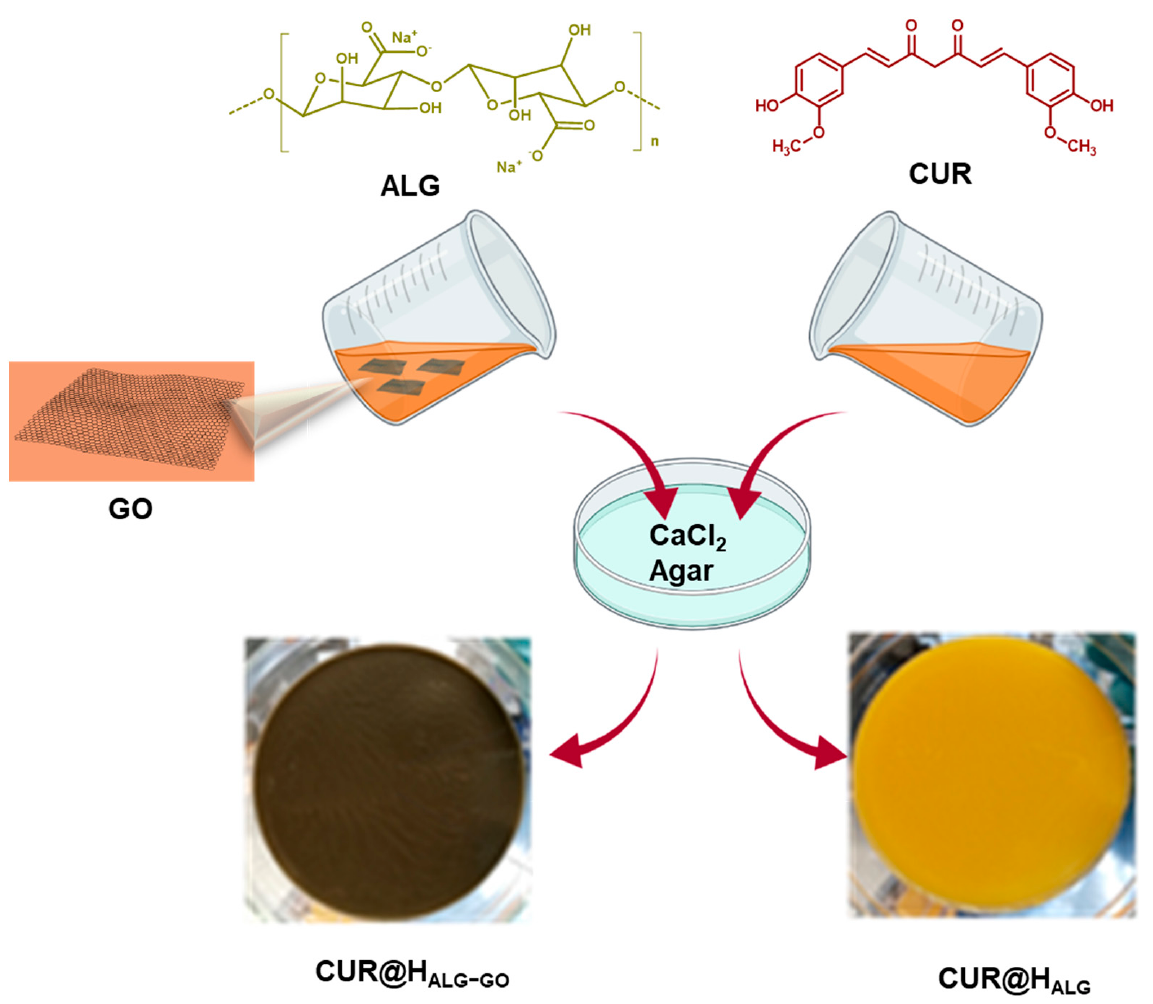
Figure 1. Schematic representation of CUR@H ALG − GO synthesis.